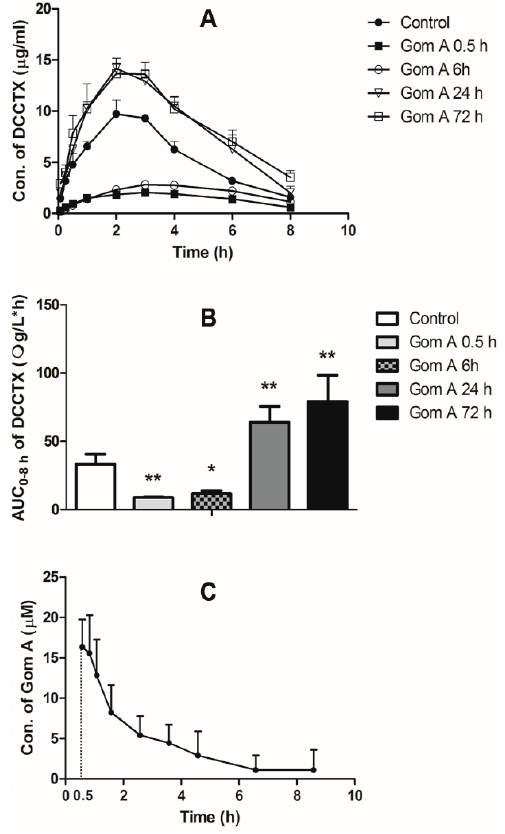
Figure 7. Blood concentration profiles of ( A ) DCCTX; ( B ) AUC 0–8h of DCCTX; ( C ) Gom A after CTX administration in group 1 − 5; ( D ) in group 1 − 5. Group 1, CTX alone group, 10 mL/kg saline (i.g.), Group 2 − 5 were given Gom A (i.g.) at the dose of 20.8 mg/kg (50 µmol/kg). In group 1, rats were administrated with CTX 0.5 h after saline administration. In group 2 − 5, rats were administrated with CTX (i.v.) 0.5 h, 6 h, 24 h and 72 h after Gom A pretreatment, respectively.